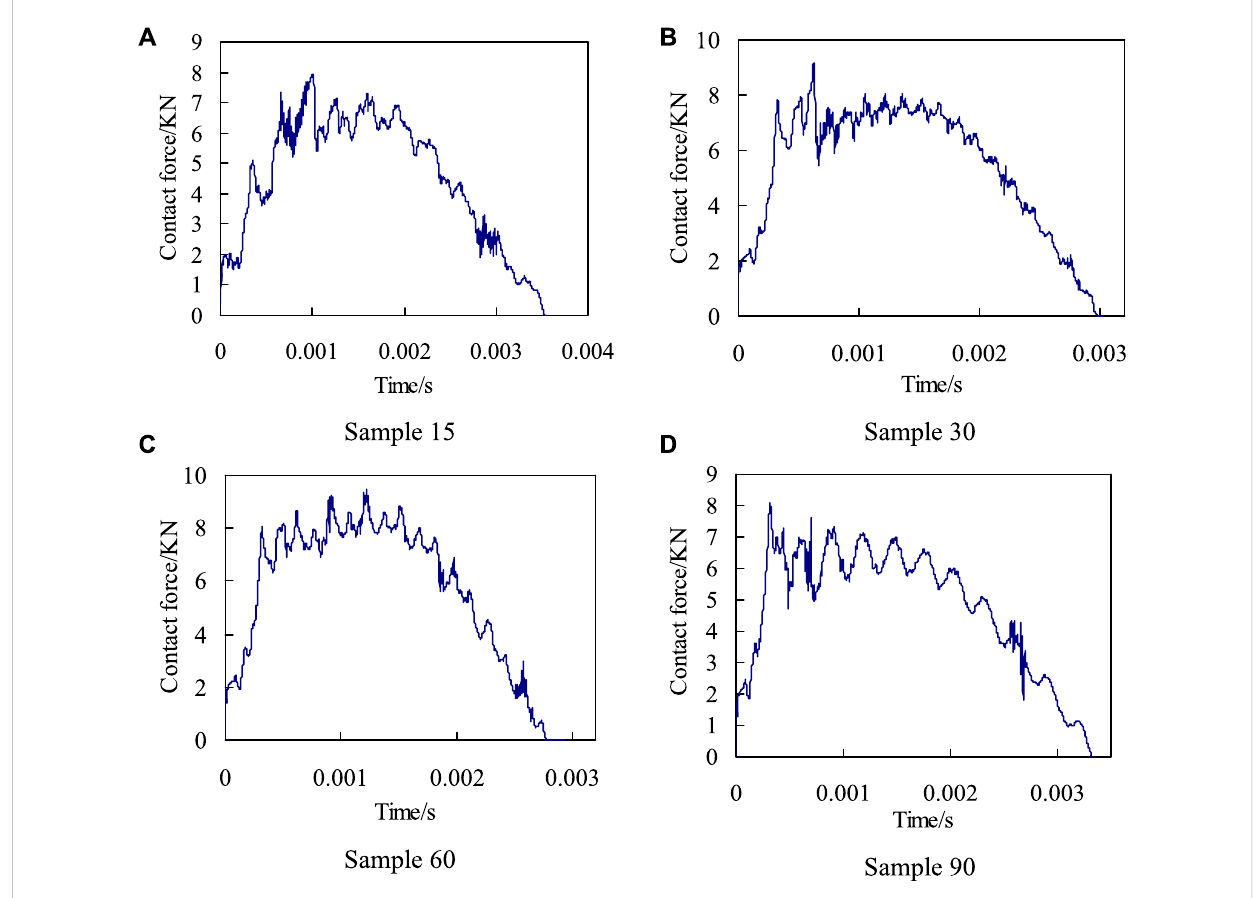
FIGURE 5 The curves of impact force-time history when the impact energy is 20 J. (A) Sample 15, (B) Sample 30, (C) Sample 60, and (D) Sample 90.